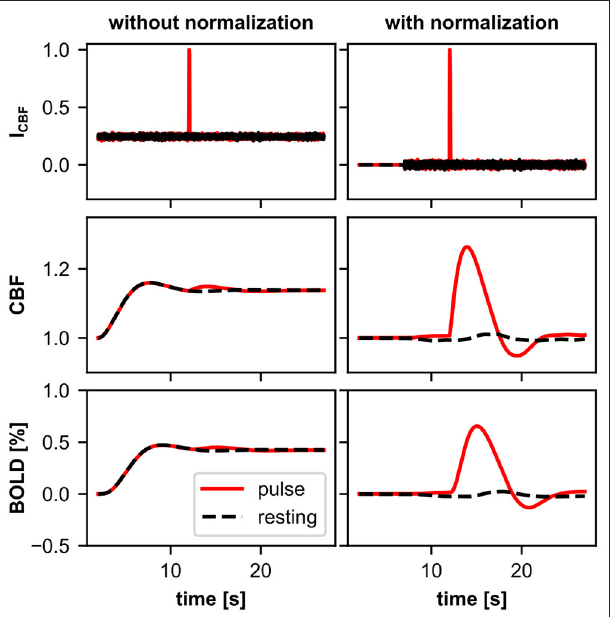
FIGURE 5 | Recordings from two BOLD monitors with (right) and without (left) baseline normalization. Shown are the averaged recordings of 40 resting-state simulations (black) and 40 simulations with a 100 ms stimulus pulse (red). Both BOLD monitors use the same source variable of the same underlying microcircuit model. For the BOLD monitor with baseline normalization, the input signal to the Balloon model ( I CBF ) corresponds to the relative change in the signal from the source variable, thus fluctuates around zero. Whereas, without baseline normalization, the input signal has an offset greater than zero. Thus, with baseline normalization only, the normalized CBF signal and the BOLD signal of the Balloon model during the resting-state are approximately one and zero, respectively, corresponding to the definition of the Balloon model. The response to the stimulus pulse is more pronounced with baseline normalization. For visualization, I CBF values are shown divided by their maximum value.